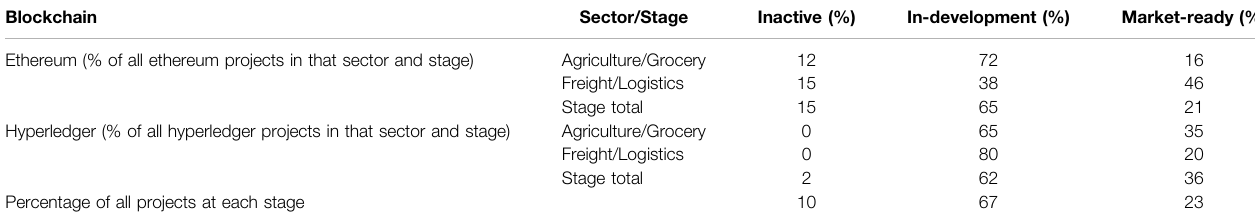
TABLE 3 | Comparison of projects that use Hyperledger and Ethereum within the Agriculture/Grocery and Freight/Logistics sectors. a